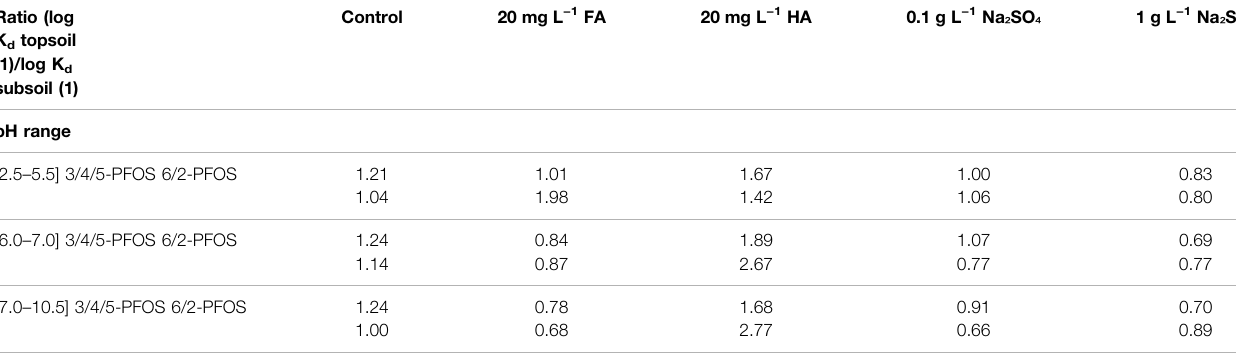
TABLE 4 | Ratio of logarithmic coef fi cients of Br-PFOS between topsoil and subsoil. Ratio (log K d topsoil (1)/log K d subsoil